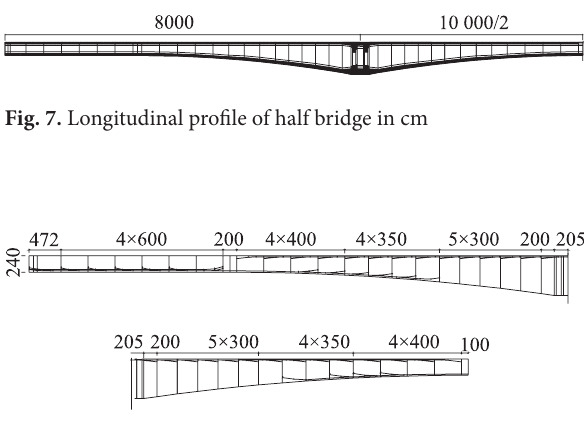
Fig. 8. Layout of the prestressing system of half bridge in cm